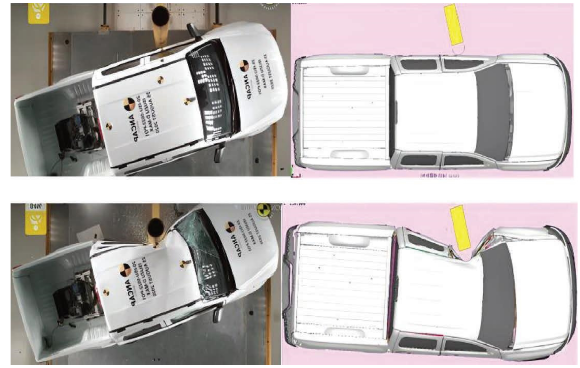
Figure 20: Sequence of side pole crash FEA vs. real NCAP crash tests.